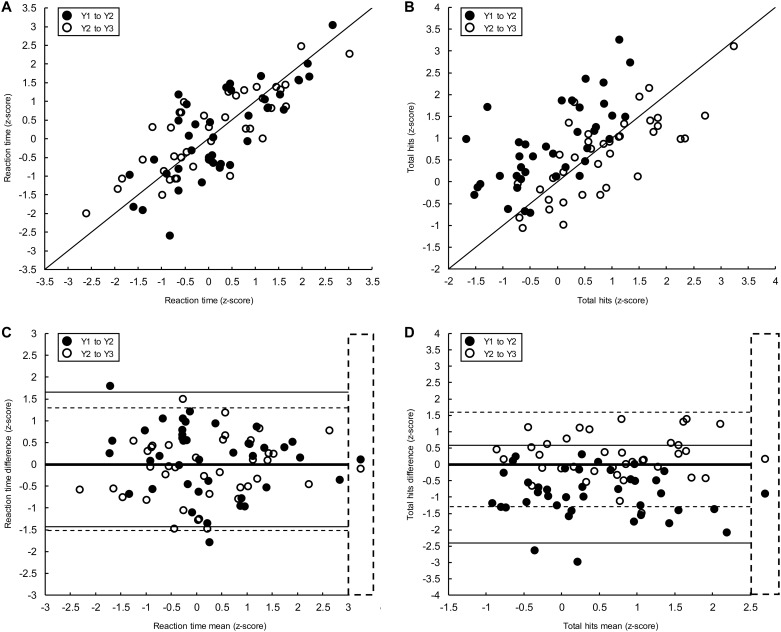
Scatter plots (top) and B-A plots (bottom) for representative parameters in the VGR (left) and OH (right) tasks from the year-to-year test-retest reliability study.On scatter plots (A and B), filled markers represent measures taken at Y1 (x-axis) and Y2 (y-axis). Open markers represent measures taken at Y2 (x-axis) and Y3 (y-axis). The black line depicts the unity line. On B-A plots, the values depicted on the x- and y- axis were derived from measures taken at Y1 and Y2 (filled markers), and Y2 and Y3 (open markers). Horizontal lines show 95% limits of agreement (Y1 to Y2, solid line; Y2 and Y3, dashed line). The thick black horizontal lines denote no difference (zero, line of equality) in performance between assessments. Markers in the dashed line box represent mean differences in performance between assessments.